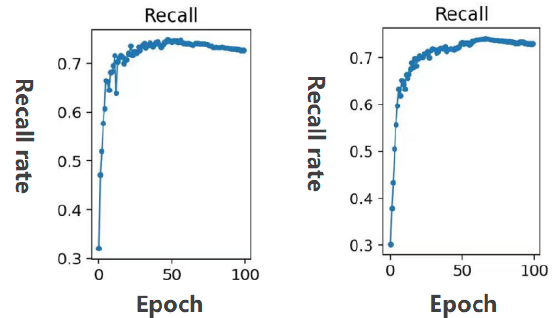
Figure 11. Recall comparison between YOLOv3 with auxiliary network and the method in this paper. The recall of the YOLOv3 model with auxiliary network on the left, and the recall of the improved model in this paper on the right. (The horizontal coordinate is the number of epochs and the vertical coordinate is the recall rate).